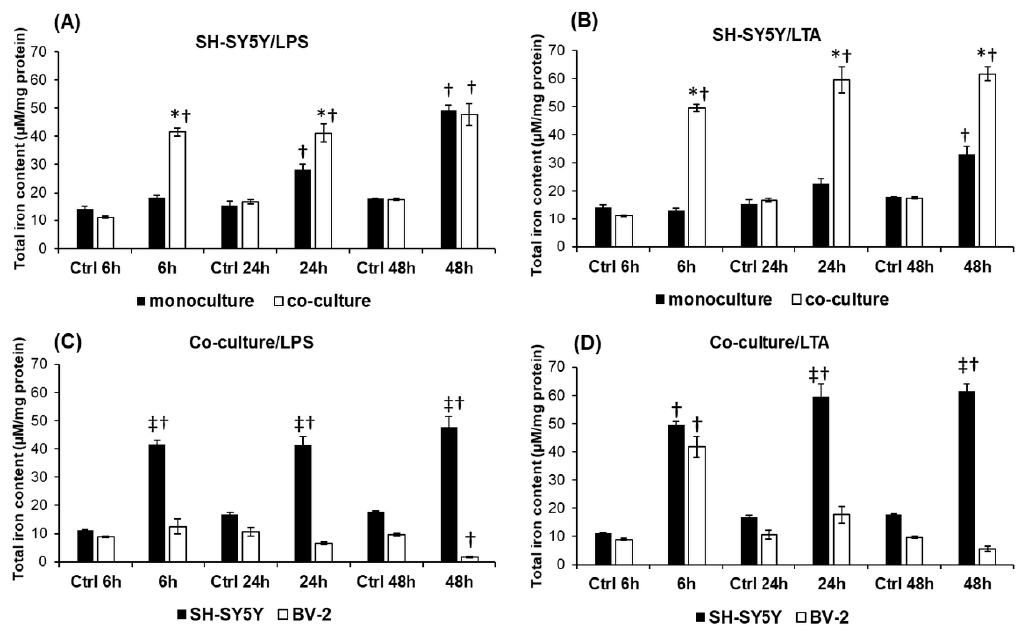
Figure 8. Comparisons of the total iron contents of mono- and co-cultured SH-SY5Y cells and co-cultured SH-SY5Y and BV-2 cells. Intracellular iron contents of SH-SY5Y and BV-2 cells were determined using a colorimetric ferrozine-based assay. Iron contents of the untreated control cells were measured the same way and at the same time points of the experiments (6 h, 24 h, and 48 h). ( A ) Total iron contents of LPS-treated mono- and co-cultured SH-SY5Y cells. ( B ) Total iron contents of the LTA-treated mono- and co-cultured SH-SY5Y cells. ( C ) Intracellular iron contents of SH-SY5Y cells and BV-2 cells in LPS-treated co-cultures. ( D ) Intracellular iron contents of SH-SY5Y cells and BV-2 cells in LTA treated co-cultures. The columns represent mean values and error bars represent standard errors of the mean (SEM) of four independent determinations. Asterisk stands for p < 0.01 between mono- and co-cultures. Double cross means p < 0.01 between SH-SY5Y cells and BV-2 cells. Cross means p < 0.01 compared to the controls.